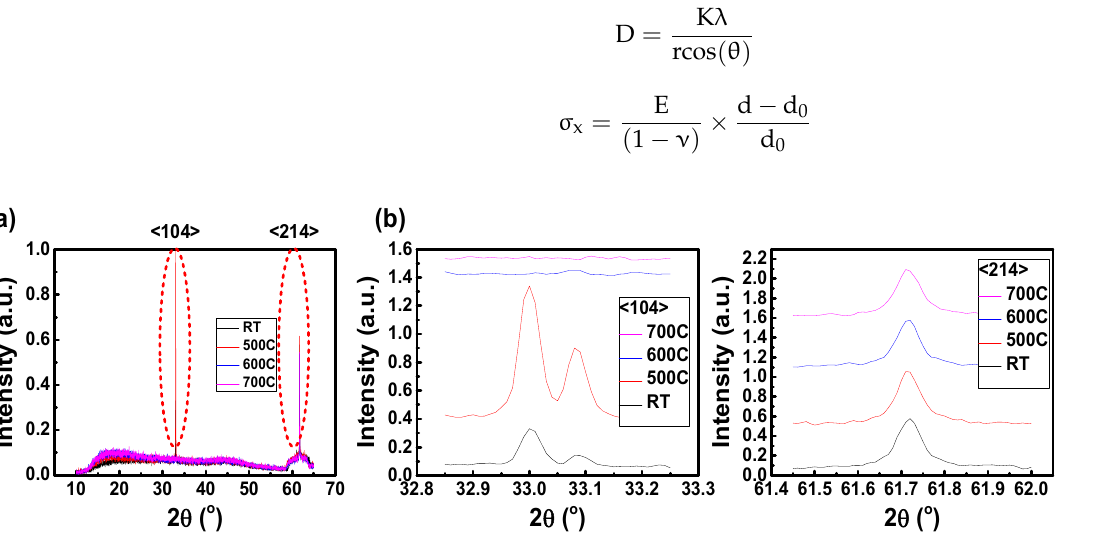
Figure 6. ( a ) The XRD measurements of the film without annealing, after annealing at 500 °C for 5 min, after annealing at 600 °C for 5 min, and after annealing at 700 °C for 5 min; ( b ) the XRD peak at the <104> and <214> crystal plane.